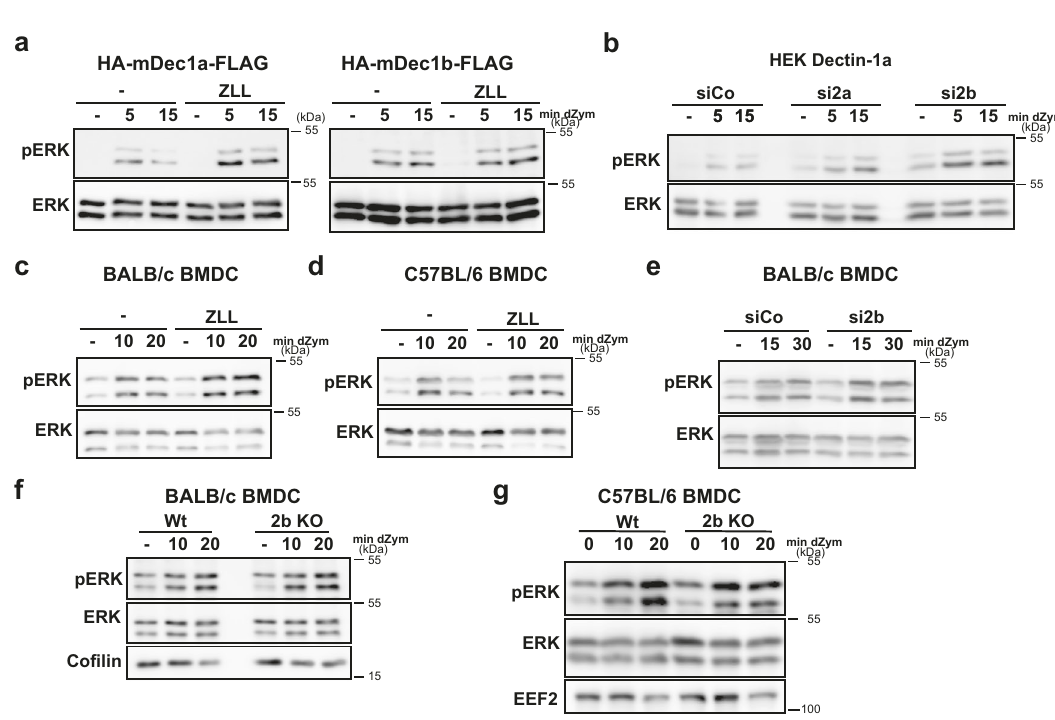
Fig. 4 Intramembrane cleavage of the Dectin-1a NTF terminates signal transduction. a HEK cells stably transfected with either HA-mDectin-1a-FLAG or HA-mDectin-1b-FLAG were serum-starved for 1 h and treated with 40 µ M ZLL or the equivalent amount DMSO ( − ) for 30 min prior to stimulation with 50 µ g/ml depleted Zymosan (dZym) for the indicated time points. Phosphorylation of ERK1/2 was evaluated using the indicated antibodies. Dectin-1a: N = 5, n = 5; Dectin-1b: N = 4, n = 4. b Expression of endogenous SPPL2a and SPPL2b was down-regulated by treatment with 50 nM of corresponding speci fi c siRNAs in HEK cells stably overexpressing Dectin-1a. After serum starvation for 1 h, cells were stimulated with 50 µ g/ml dZym and subjected to western blot analysis for ERK1/2 phosphorylation. N = 3, n = 5. c BALB/c BMDC were serum-starved for 1 h in the presence of either DMSO or 40 µ M ZLL. Subsequently, cells were treated for the indicated time points with 50 µ g/ml dZym. Levels of phosphorylated as well as total ERK1/2 were visualised by western blotting. N = 2, n = 6. d BMDC from C57BL/6 mice were treated as described in c . N = 2, n = 4. e BALB/c BMDC were treated with either control or SPPL2b-targeting siRNA. Subsequently, cells were subjected to analysis of signal transduction as described in previous sub fi gures. N = 1, n = 3. f Either wild type (Wt) or SPPL2b-de fi cient (2b KO) BALB/c BMDC were serum-starved for 1 h and subsequently treated for the indicated time points with 50 µ g/ ml dZym. Activation of ERK1/2 was determined by western blotting. N = 2, n = 6. g The same experiment was performed with mice with the same genotypes but on C57BL/6 background. N = 2, n =